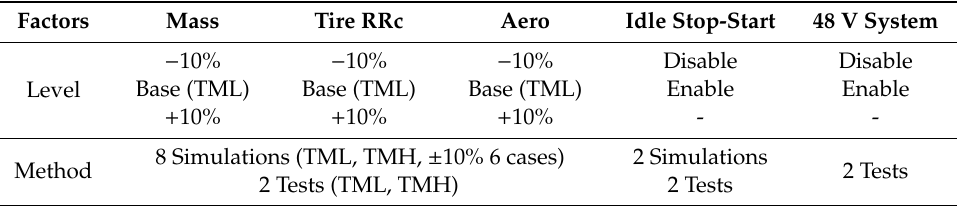
Table 5. Factors for fuel consumption contribution analysis in NEDC and WLTP.